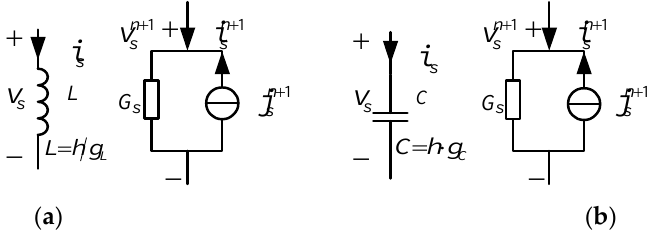
Figure 1. Associated Discrete Circuit (ADC) switch model: ( a ) on; ( b ) off.